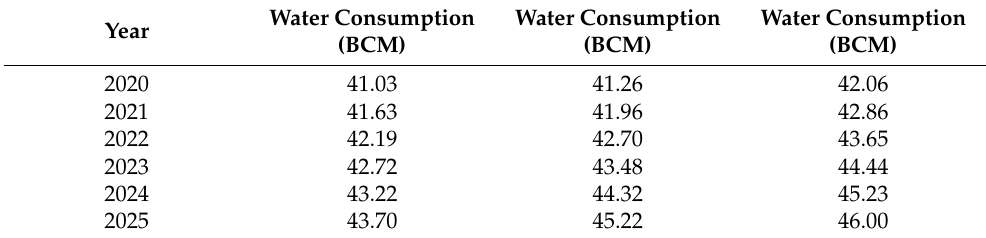
Table 4. Beijing’s water consumption under the influence of different industries from 2020 to